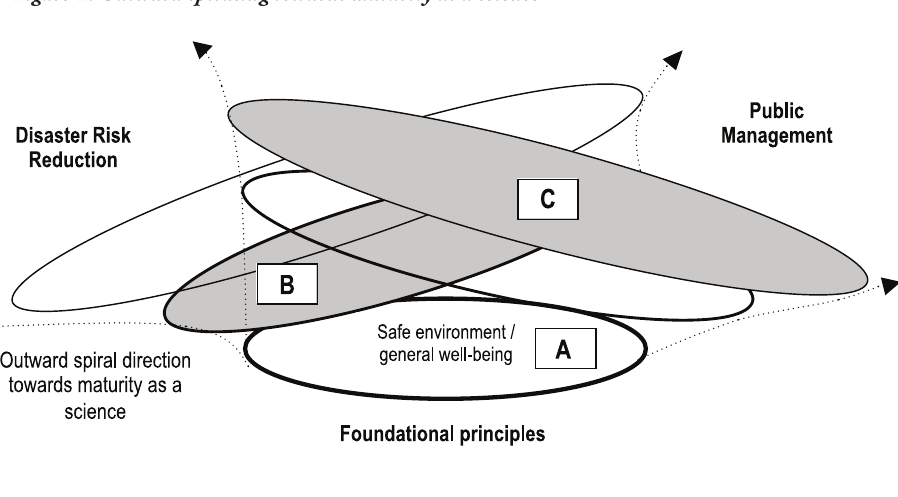
Figure 1: Outward spiraling towards maturity as a